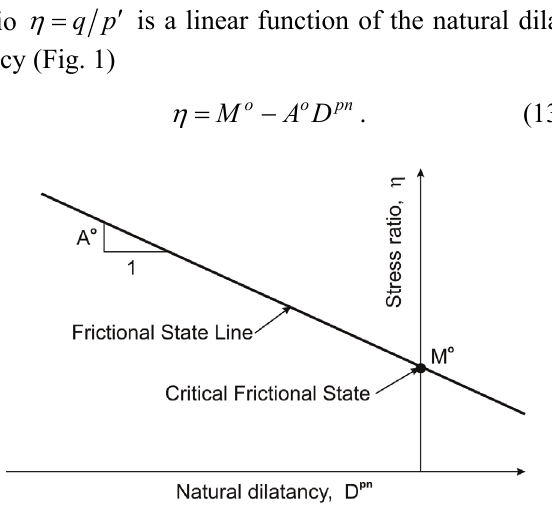
Fig. 1. Stress ratio and natural dilatancy relationship for the frictional state In the pn D  plane, the frictional state for con- stant A o is represented by a straight line that is named the frictional state line , as shown in Fig. 1; Coop and Wilson [4] named this line the frictional trend line